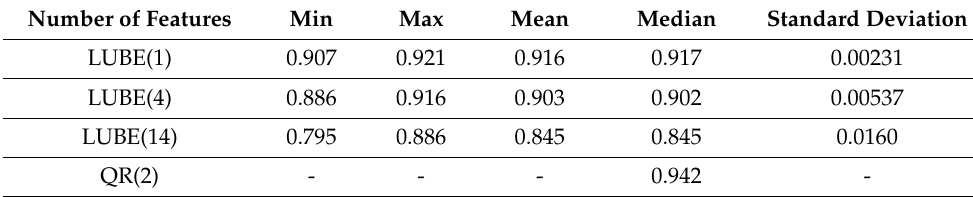
Table 4. Statistics of 2-week average PICP. Figure 7. Number of features and 2-week average PICP in LUBE and QR.